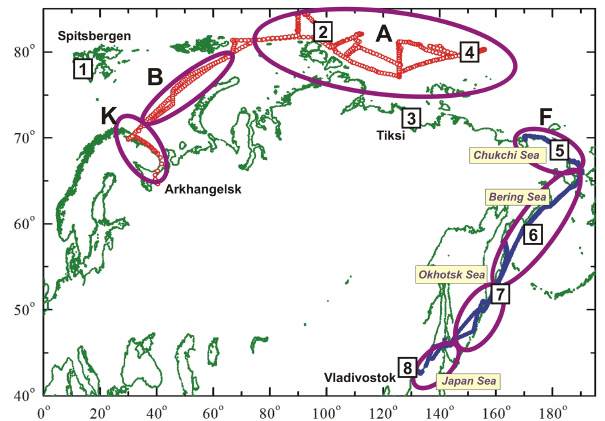
Figure 1. Map of the routes of Arctic cruises of RV Akademik Fe- dorov and Professor Khljustin . Numbers indicate the regions where AOD values were calculated; letters and ovals indicate the sections of the routes within which the aerosol microphysical parameters were